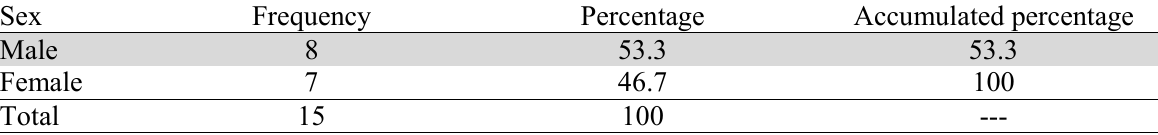
Distribution of the traditional group based on sex